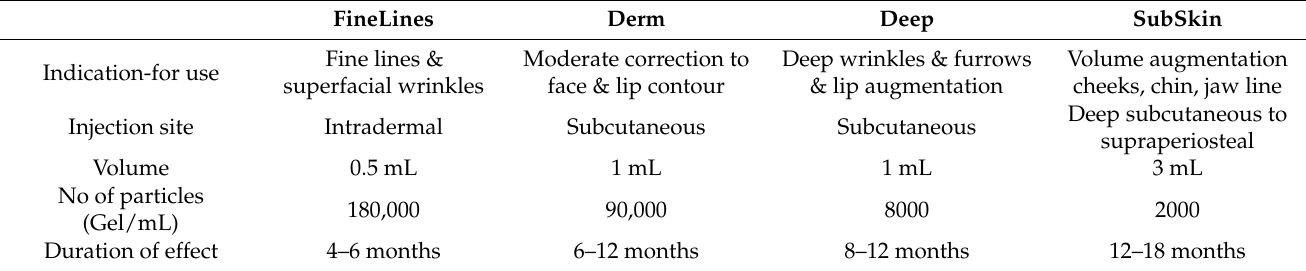
Table 7. Product description of Perfectha ® Hyaluronic Acid dermal fillers.